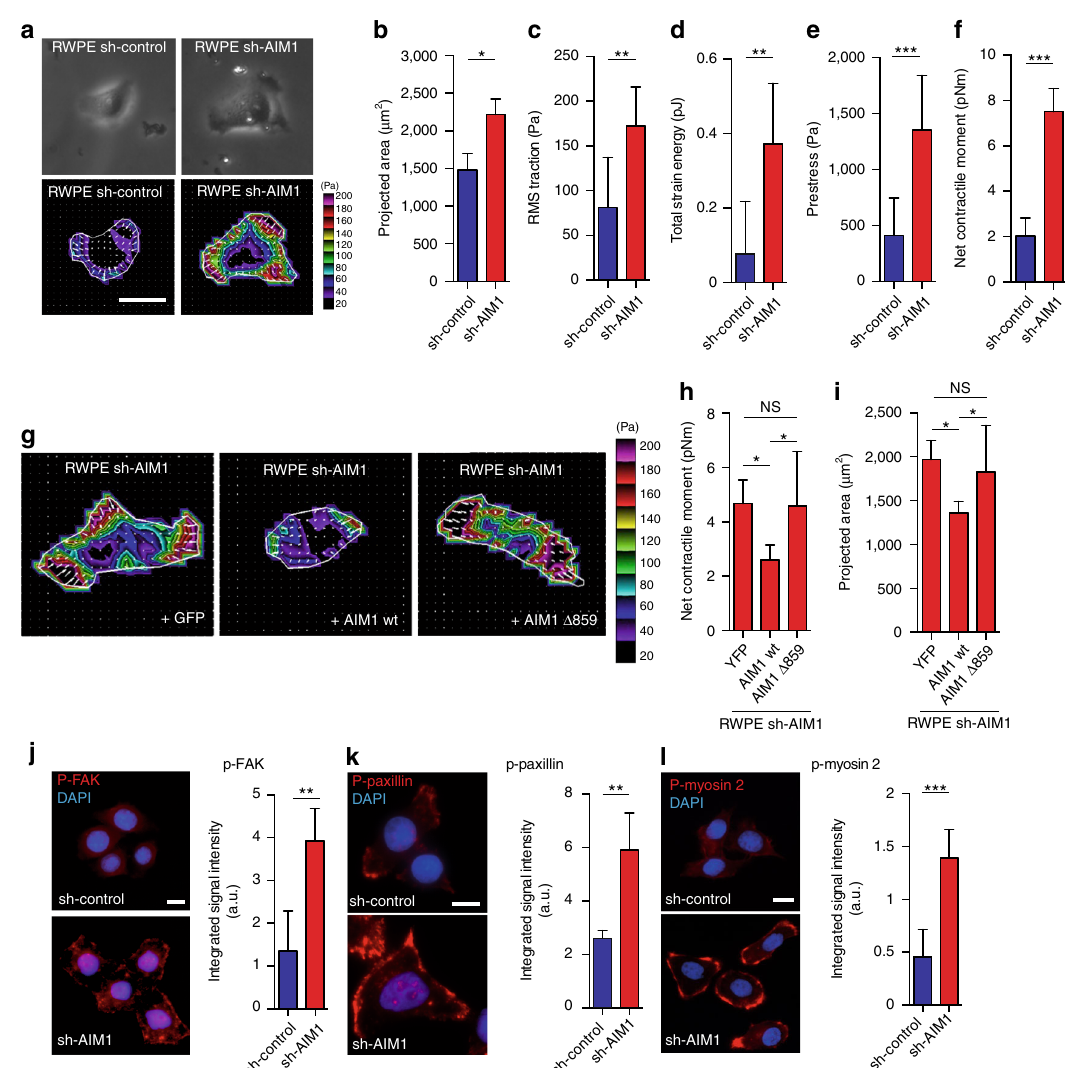
Fig. 4 AIM1 depletion increases cytoskeletal remodeling, cellular traction forces and focal adhesions in prostate epithelial cells. a Representative images of phase contrast and Fourier transform traction microscopy (FTTM) for RWPE-1 sh-AIM1 and sh-control cells, show the magnitude ( colorscale ) and direction ( arrows ) of traction forces. Scale bars indicate 10 μ m. From these FTTM experiments, projected area ( b ), root-mean-squared (RMS) traction force ( c ), total strain energy ( d ) prestress force ( e ), and net contractile moment ( f ) were determined, showing signi fi cant increases in sh-AIM1 compared to sh-control RWPE-1 cells for all measures. g – i From traction force vectors ( g ), the calculated net contractile moments ( h ), and projected cellular area ( i ) of RWPE-1 sh-AIM1 “ rescued ” with YFP control, wild-type AIM1 or AIM1 Δ 859 are shown. Note that expression of wild-type AIM1 can rescue the increased contractile moment and projected area in RWPE-1 sh-AIM1 cells. j – l Immuno fl uorescence microscopy experiments revealed that levels of phosphorylated focal adhesion kinase (p-FAK) ( j ), phosphorylated paxillin (p-paxillin) ( k ), and phosphorylated myosin 2 (p-myosin 2) ( l ), were signi fi cantly increased in sh- AIM1 compared to sh-control RWPE-1 cells, indicating an increase of focal adhesions in sh-AIM1 cells. a , g , j – l All microscopy images are representative of two to three independent experiments. Scale bars indicate 5 μ m. All bar plots represent mean ± SD of 20 – 50 single cells from each experiment. T -test P values, * denotes P < 0.05; ** denotes P < 0.01; *** denotes P <